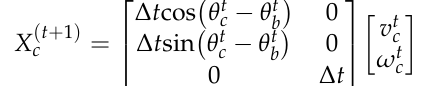
Table 1. The basic parameters of the USV studied in this work. Maximum Maximum Speed Angular Speed